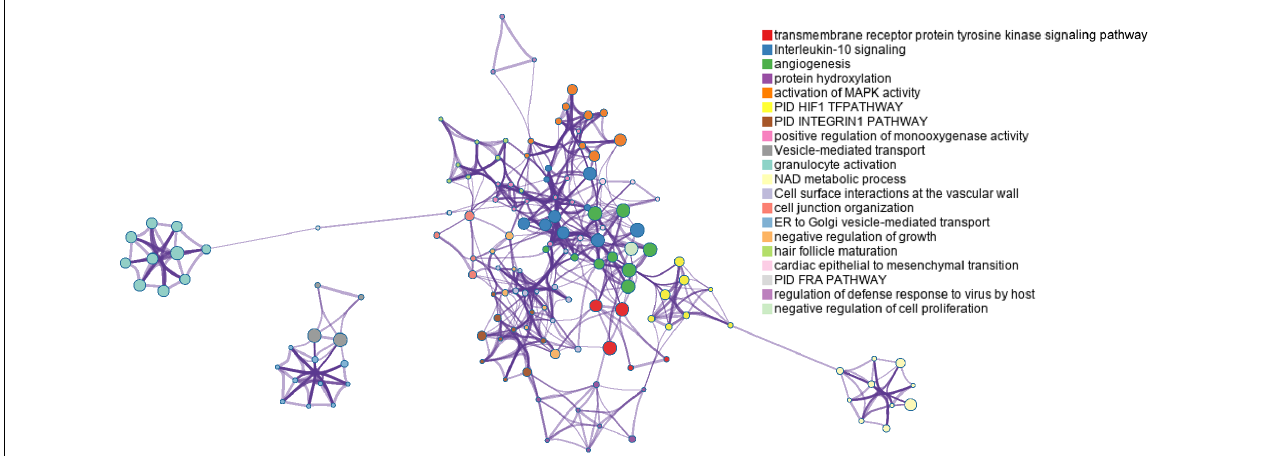
FIGURE 5 | Network of the top 20 enriched gene ontology and pathway terms colored by cluster